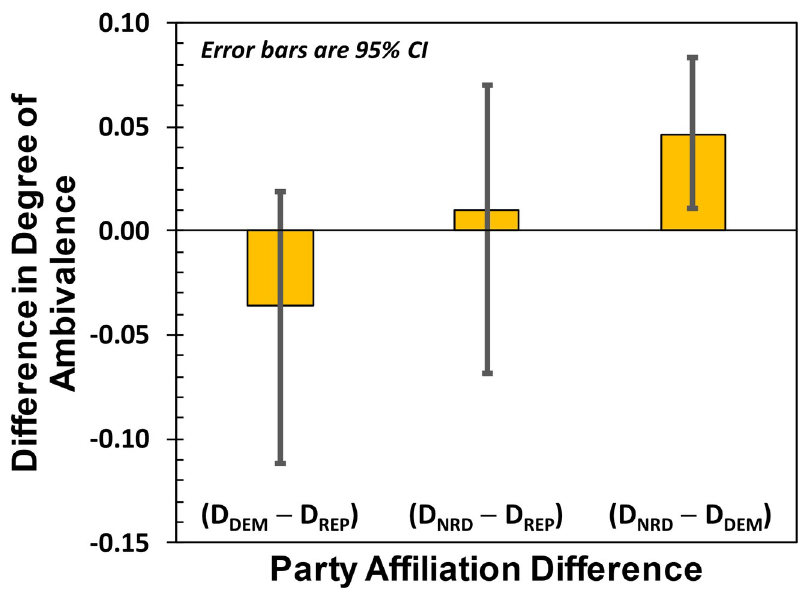
Fig 3. Difference in degrees of ambivalence, D. At the 95% confidence level, those respondents identifying as Neither Republican nor Democrat (NRD) have higher degrees of ambivalence than Democrats.